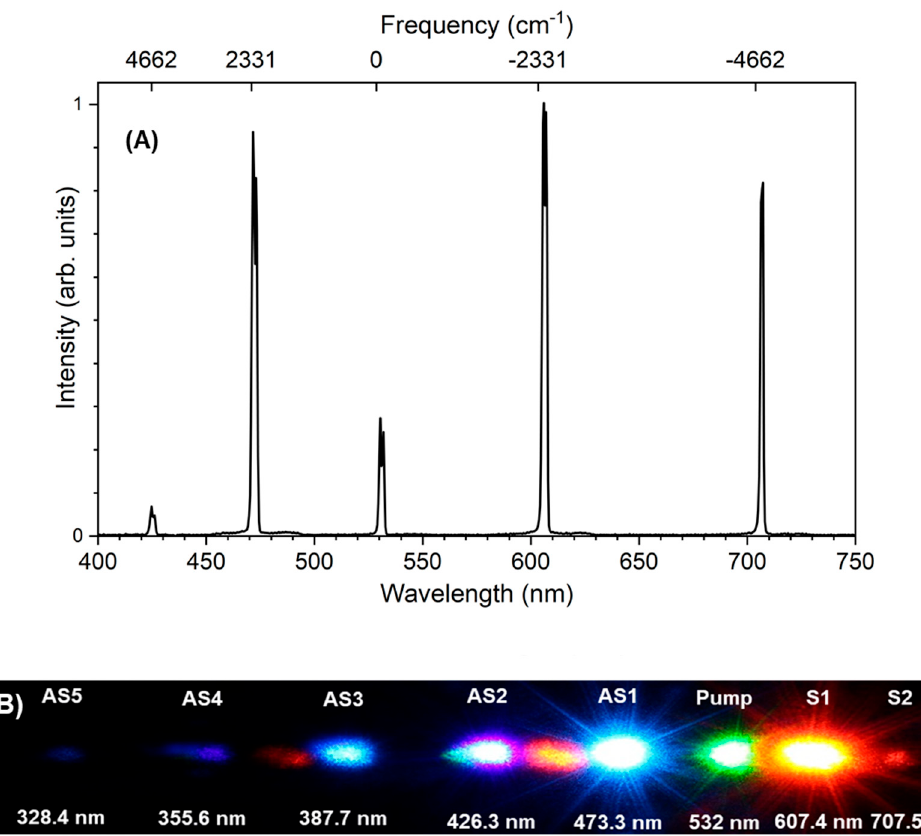
Figure 2. Spectral components of the coherent Raman generation in air: ( A ) as measured with the spectrometer. ( B ) Photo of the generated sidebands, taken with a digital camera, after a 532 nm high-reflection mirror.